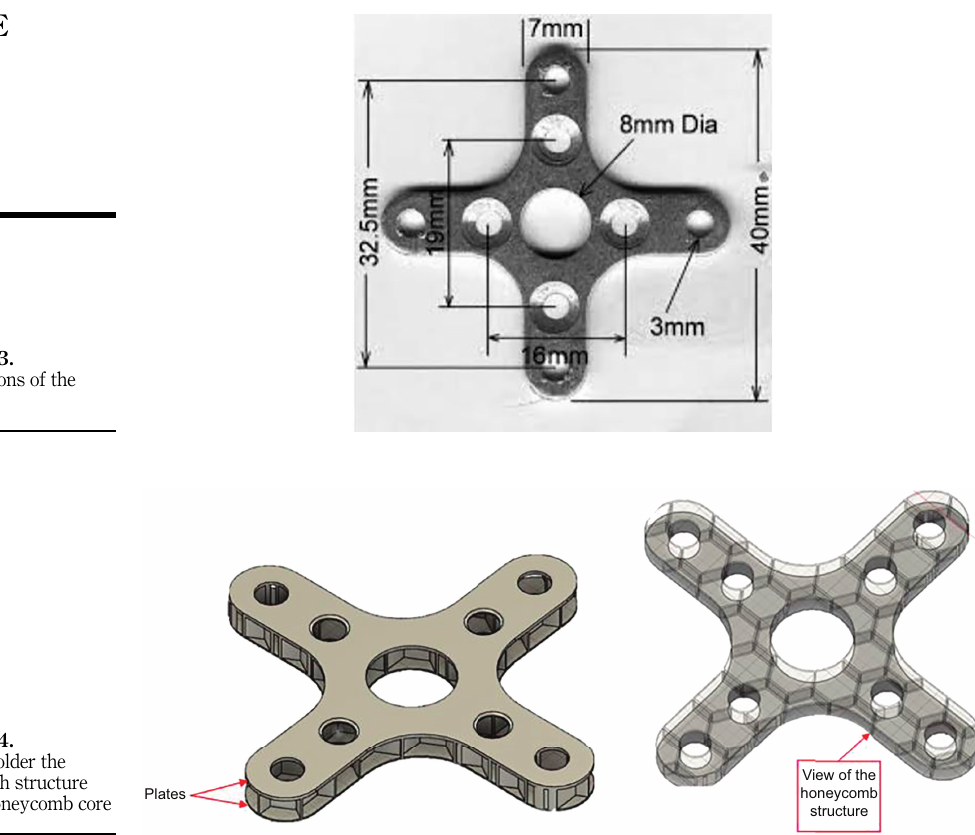
Figure 4. Motor holder the Sandwich structure and a honeycomb core